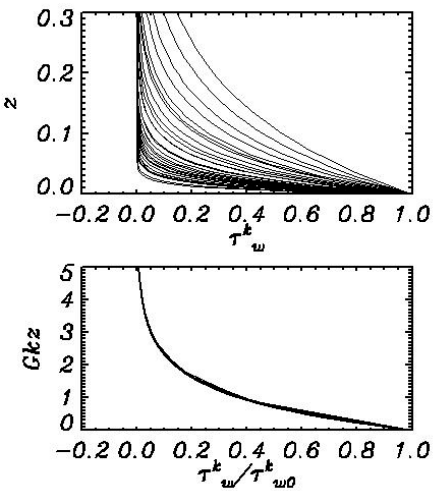
Figure 5. Upper panel: vertical profiles of Fourier components τ k w of WPMF (Wave Produced Momentum Flux) as a function of height z . Bottom panel—the same profiles, but each being normalized by their surface values τ k w 0 as a function of Gkz (Equation (19) and (20)).